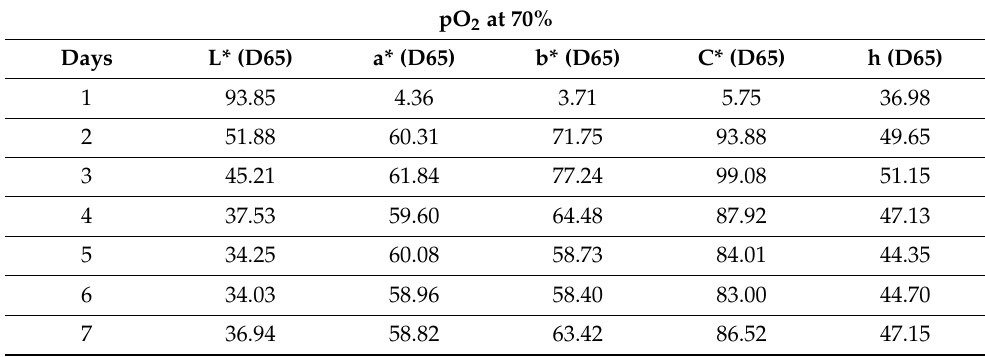
Table 5. Colorimetric (D65) values L*a*b*c*h of extracellular extracts from 2 L bioreactor fermentation with pO 2 at 70%.